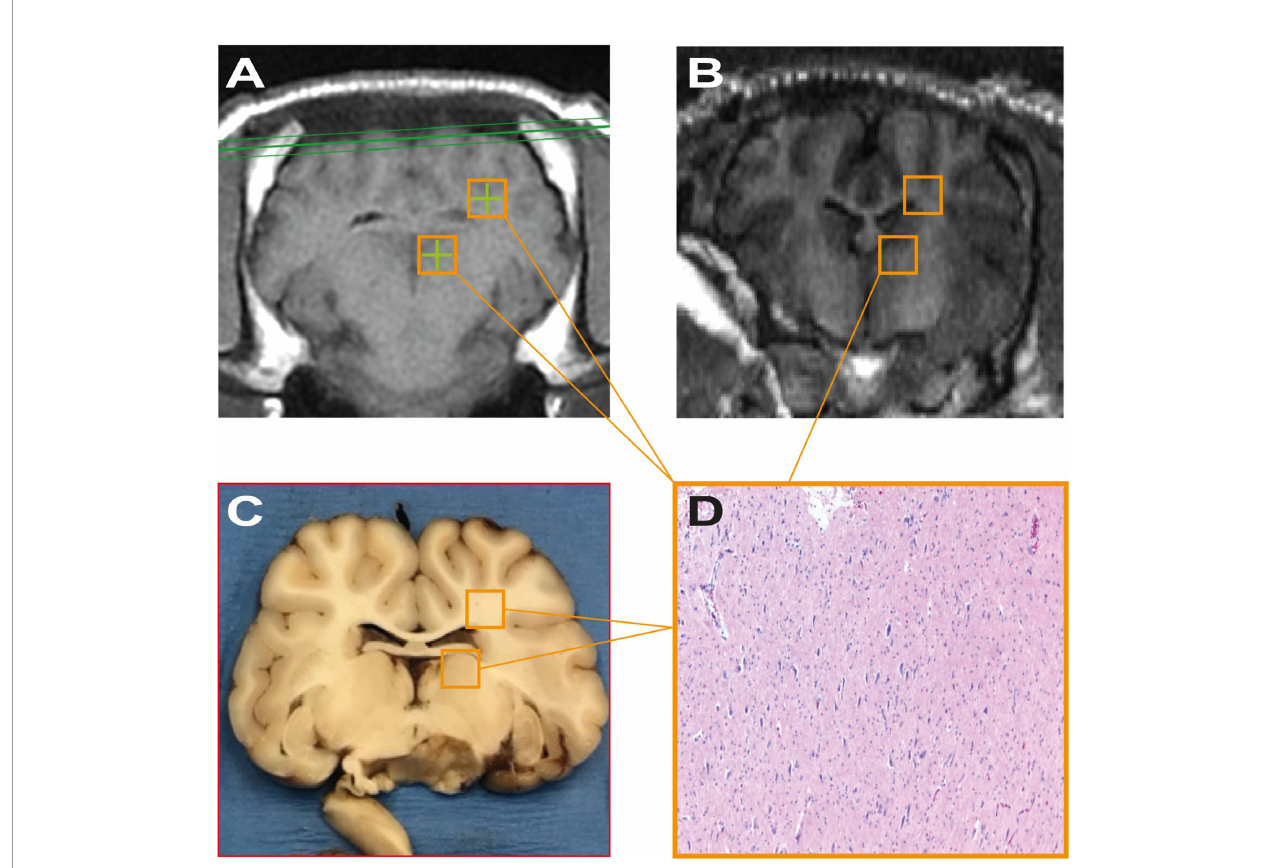
FIGURE 5 | (A, B) represent pre-treatment tracking images and post-procedure scans respectively, showing no signi fi cant differences attributable to the sonodynamic therapeutic protocol. Similarly, (C, D) were acquired during macroscopical examination and histopathological analysis of specimens and show no signs of necrosis or apoptotic phenomena after the